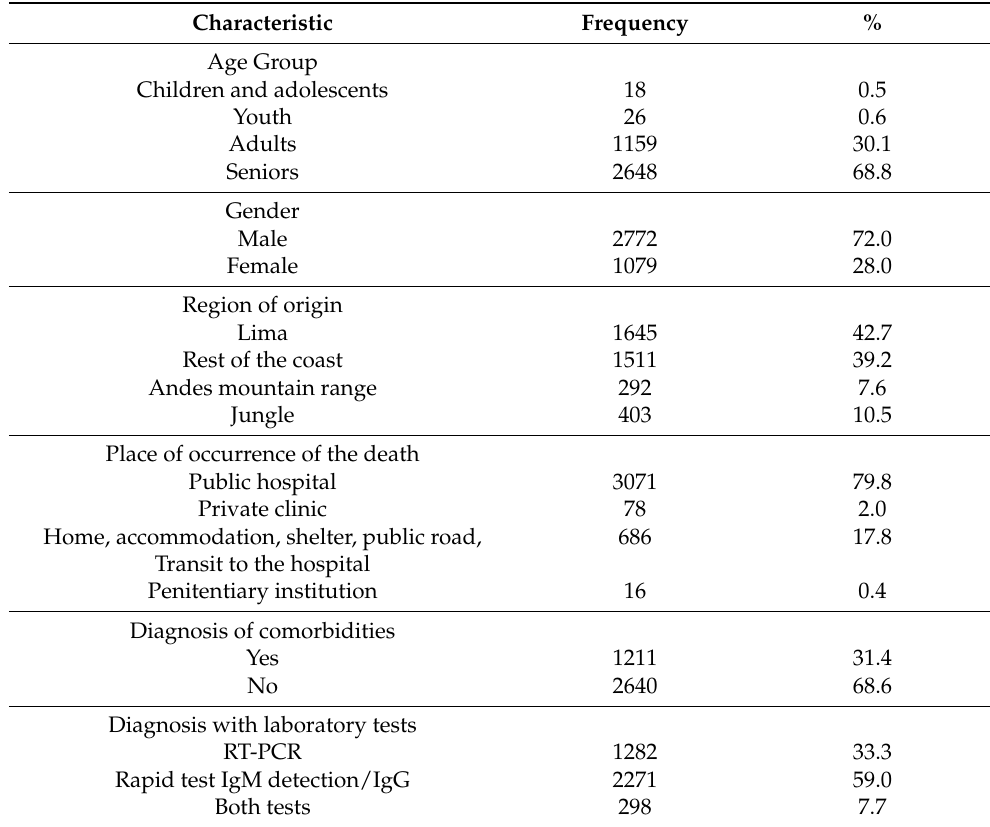
Table 1. Epidemiological characteristics of the deaths confirmed by COVID-19 in Peru.